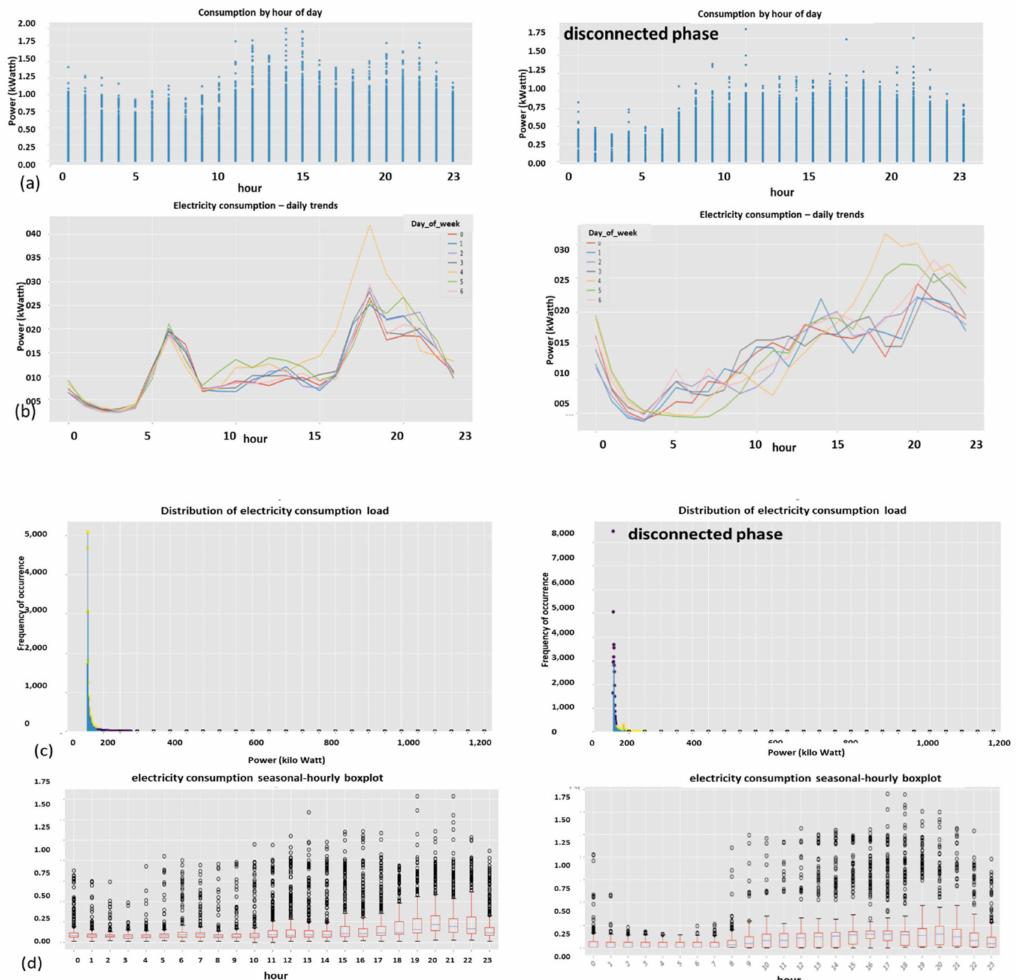
Figure 21. Phase disconnect: ( a ) scatter, ( b ) daily-hourly trends, ( c ) energy distribution, and ( d ) sea- sonal